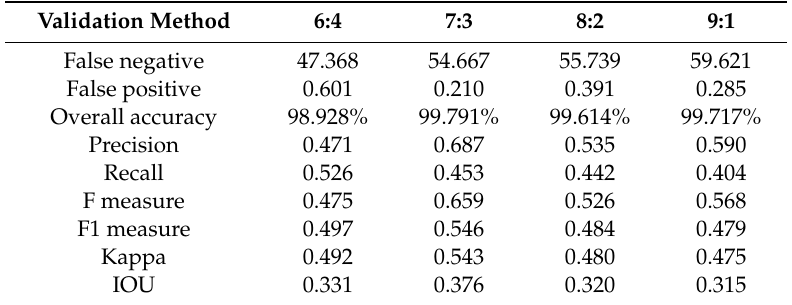
Table 4. Accuracy of the model in the different encoder 8 portions at the Bangkok site.